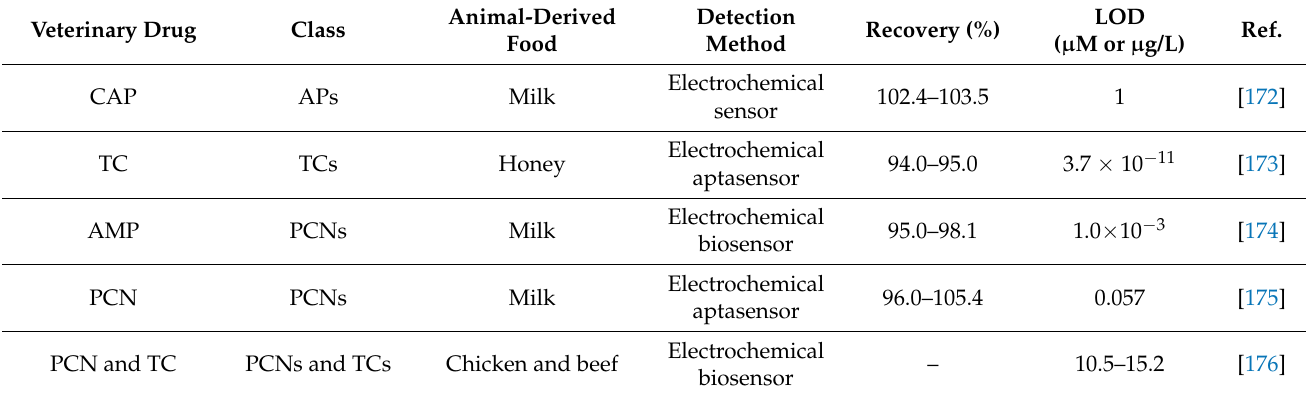
Table 6. Overview of published advanced methods for the analysis of veterinary drugs in animal-derived foods. Veterinary